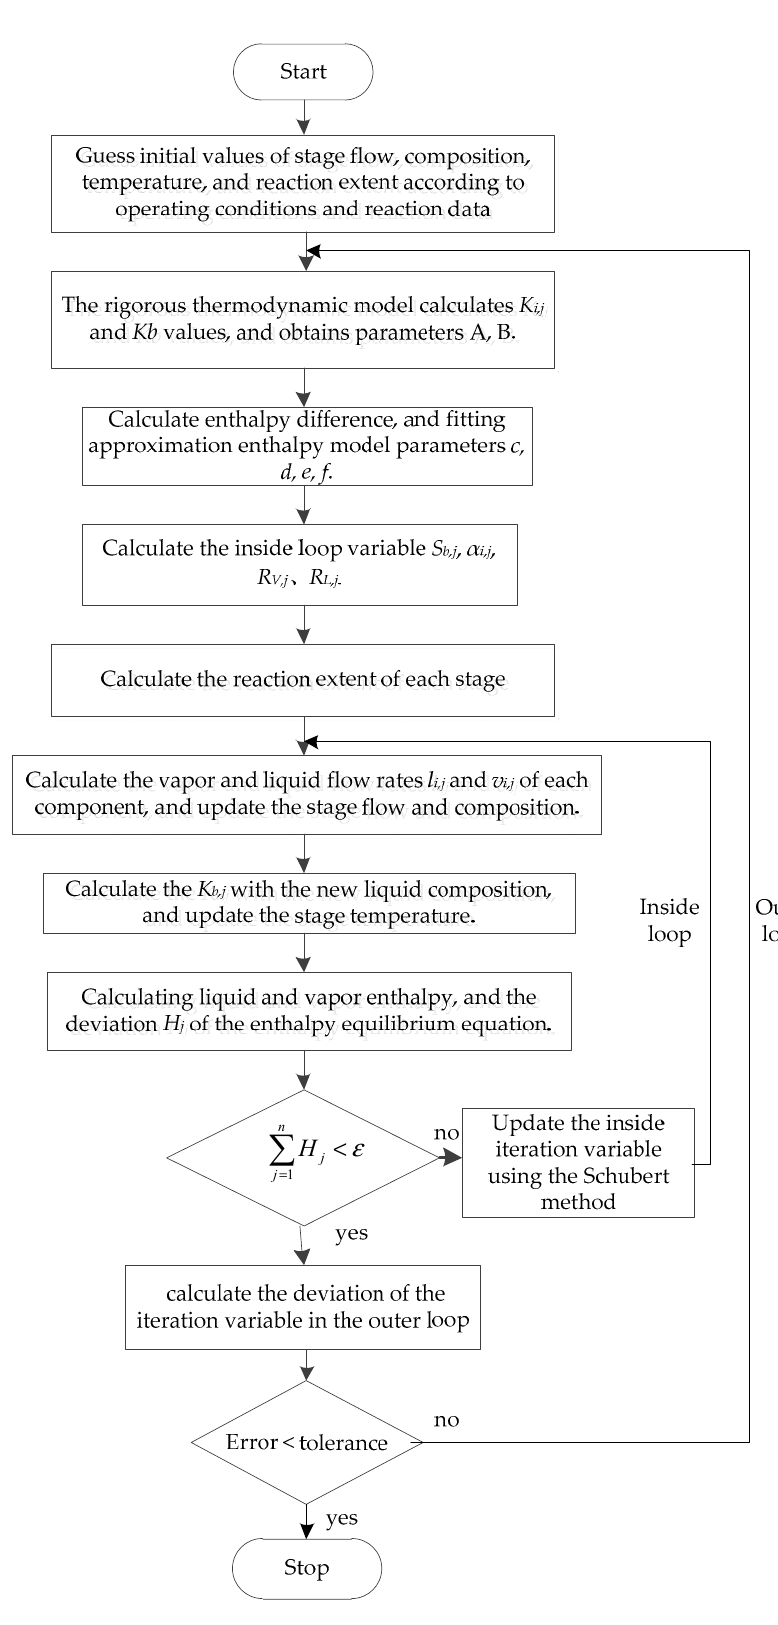
Figure 4. Calculation of the block diagram of the improved Inside–Out method.